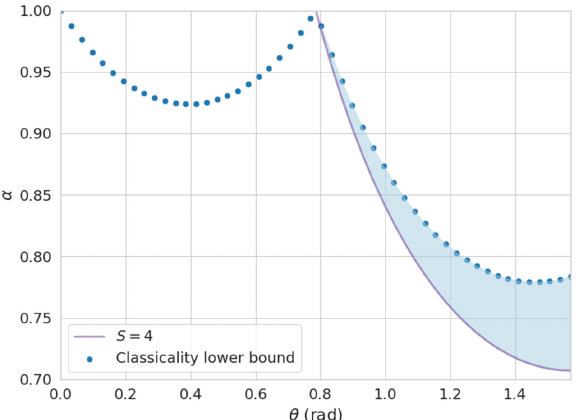
FIG. 5. Nonclassicality activation for the preparations in Fig. 4 and measurements arranged in a rhombicuboctahedron with cor- responding η ≈ 0.86. As S ∝ α , every preparation set above the S = 4 curve is nonclassical. On the other hand, the blue scatter } for α = 0.8. , ρ r , ρ r , ρ r shows the maximum visibility such that any triad of states in the 1 2 3 4 preparation set are classical. The shaded region thence stands for preparations that exhibit nonclassicality activation by increasing the number of